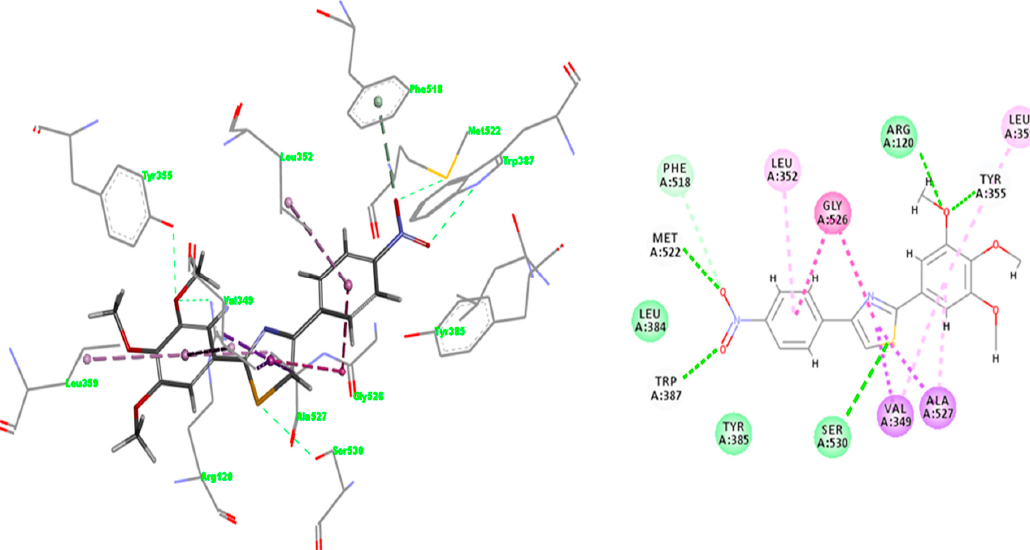
Figure 8. Induced Fit Docking ( IFD) predicted binding mode of compound A3 in COX-2 (PDBID: 4M11); H–bonds are depicted in green lines (Arg120 (3.070Å), Trp387 (2.922 Å), Met522 (2.811 Å) and Ser530 (3.000 Å), whereas hydrophobic interactions are shown in purple [28].